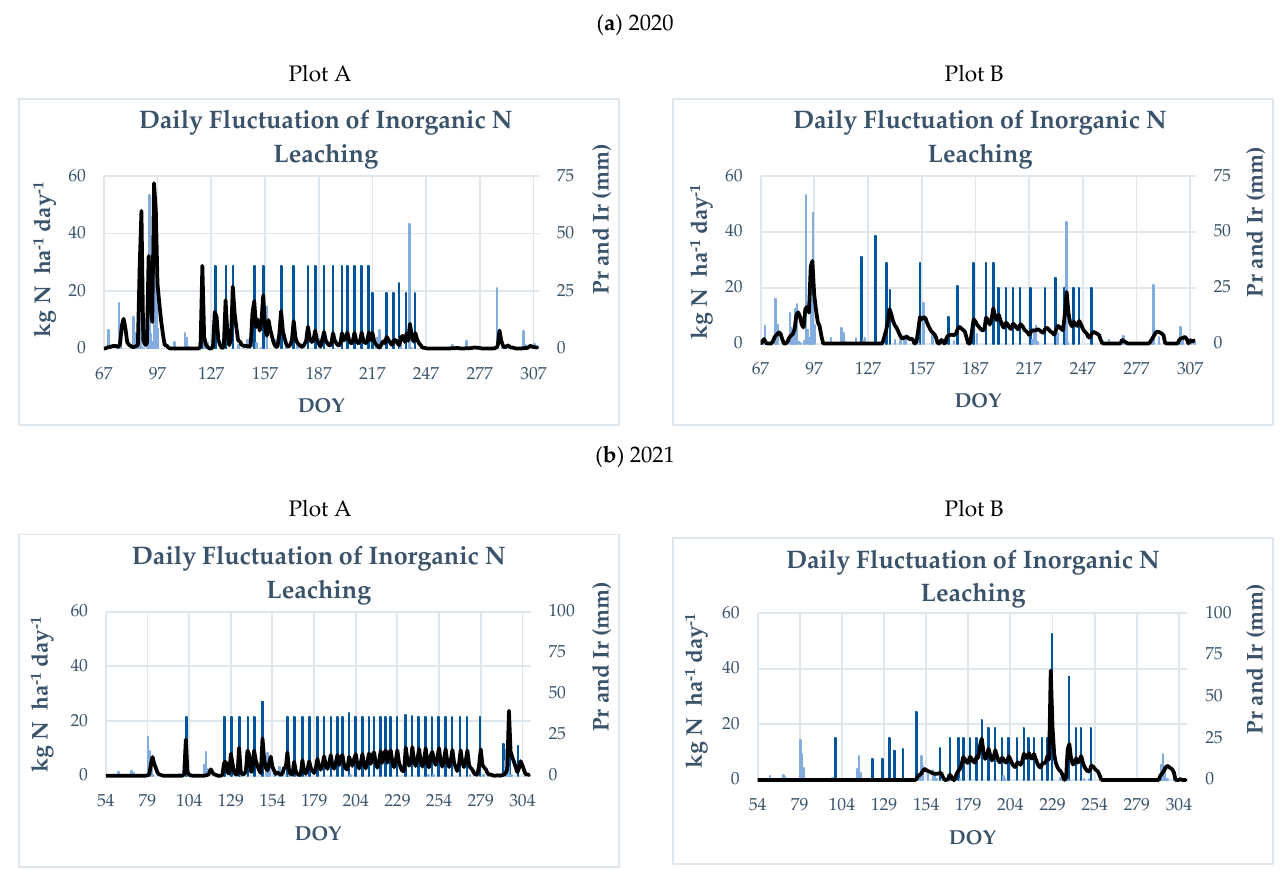
Figure 5. Daily fl uctuation of inorganic N (sum of NH 4 -N and NO 3 -N) leaching in g N ha − 1 day − 1 , for plots A and B in ( a ) 2020 and ( b ) 2021; simulated by the CropSyst model. The blue bars show precipitation (Pr), whereas the dark blue bars show irrigation (Ir) water applied.